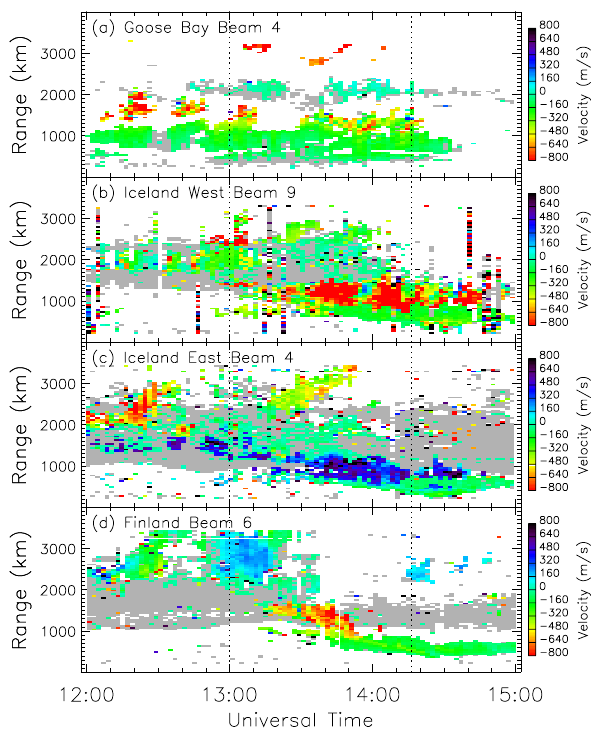
Fig. 5. Line-of-sight velocity measurements for the interval 12:00– 15:00UT on 11 February, 1998. The data are from (a) Goose Bay Beam 4, (b) Iceland West Beam 9, (c) Iceland East Beam 4, and (d) Finland Beam 6. The grey regions represent data flagged as ground backscatter by the SuperDARN raw data processing algo- rithm. Positive line-of-sight velocities represent the flow toward the radar, whereas negative line-of-sight velocities represent the flow away from the